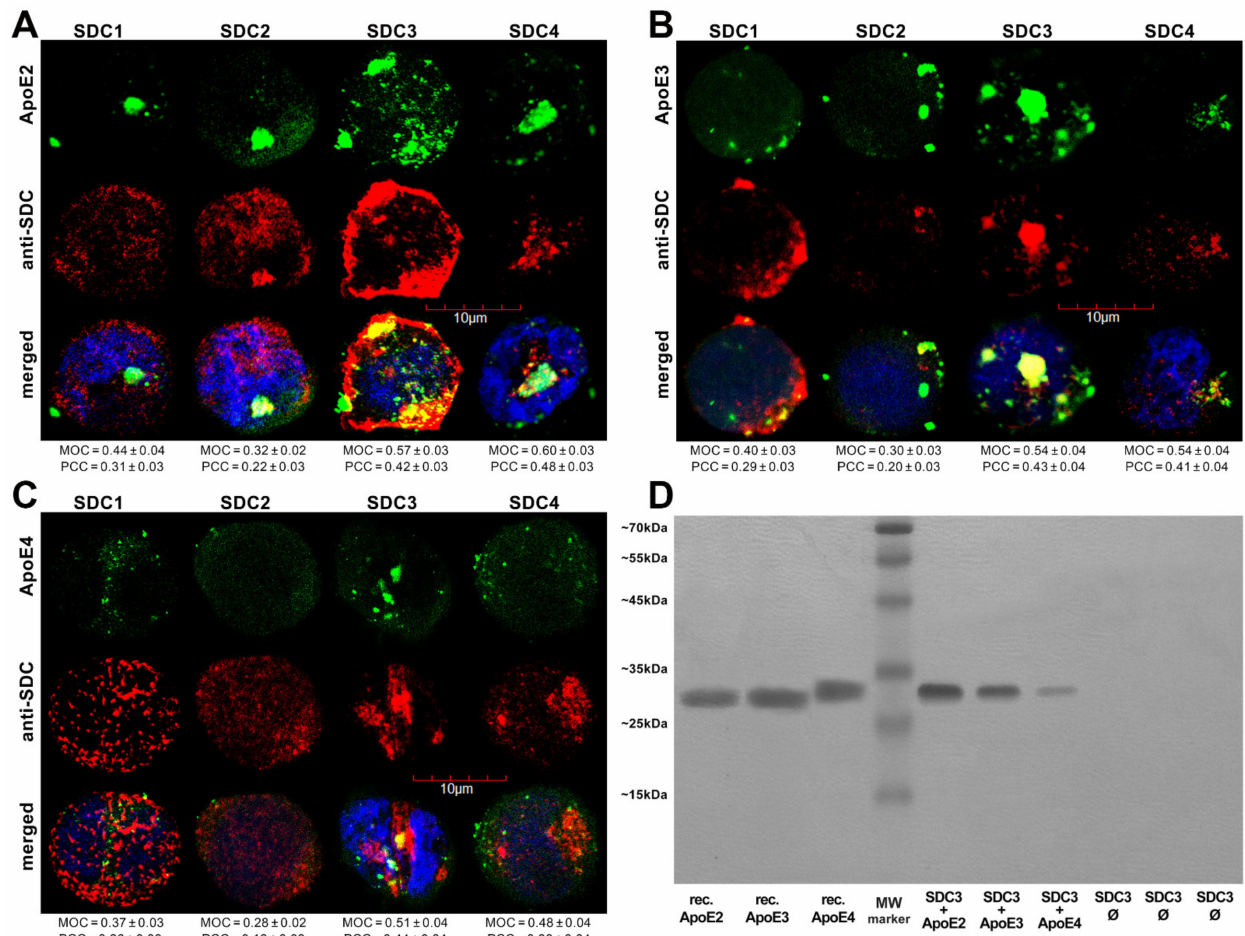
Figure 2. Colocalization of ApoEs and SDCs. SDC transfectants were treated with either of the FITC-ApoEs for 3 h at 37 ◦ C. After incubation, the cells were permeabilized and treated with the respective APC-labeled SDC antibody. Nuclei of cells were stained with DAPI and colocalization was then analyzed with confocal microscopy. ( A–C ) Confocal microscopic images of SDC transfectants treated either of the FITC-ApoEs and the respective APC-labeled SDC antibody. Representative images of three independent experiments are shown. Scale bar = 10 µ m. MOC or PCC ± SEM for the colocalization of SDCs with FITC-ApoEs was calculated by analyzing 18 images with ~7 cells in each image (from three separate samples). ( D ) SDS-PAGE showing FITC-labeled ApoEs immunoprecipitated with SDC3 from extracts of SDC3 transfectants. Lanes 1–3: 0.5 µ g of FITC-ApoEs. Lane 4: molecular weight (MW) marker. Lanes 5–7: immunoprecipitates of SDC3 transfectants treated with either of the FITC-ApoEs. Lanes 8-10: immunoprecipitates of untreated SDCs transfectants. Standard protein size markers are indicated on the left. Image acquisition was carried out with UVITEC Alliance Q9 Advanced